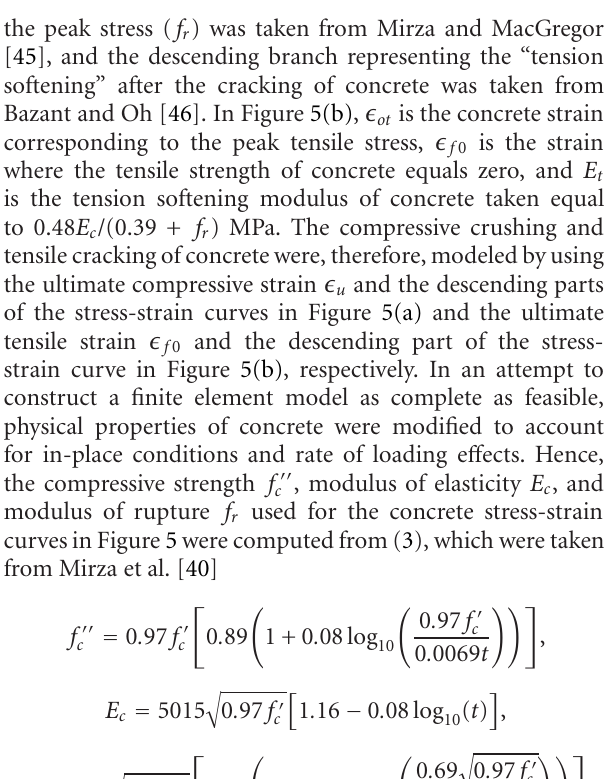
Figure 5: Schematic stress-strain curves used for FEM for concrete in (a) compression, and (b)